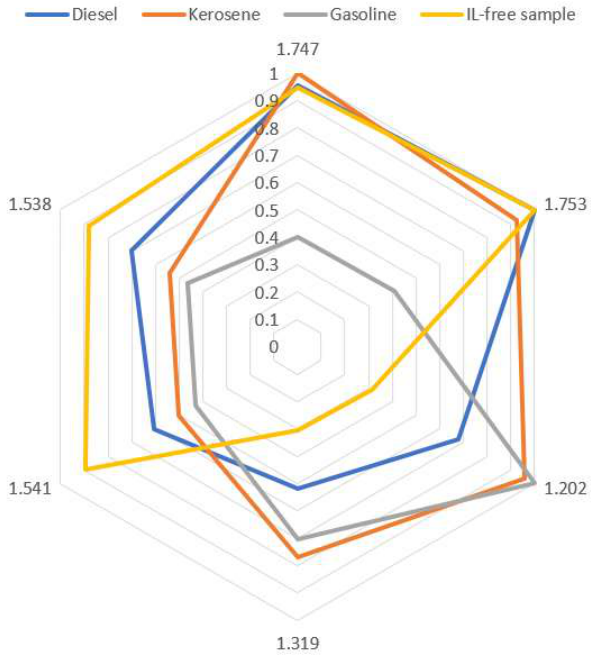
Figure 3. Fingerprint resulting from the drift times selected from the linear discriminant analysis